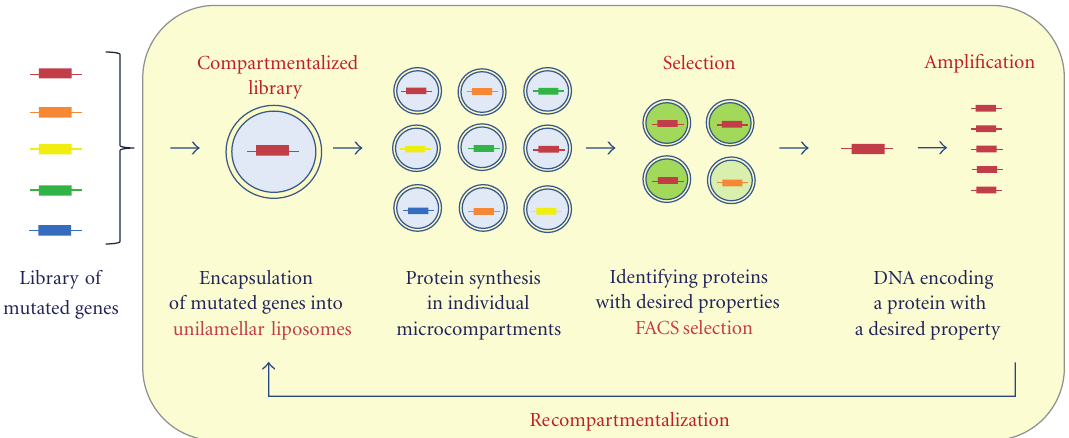
Figure 6: Flow chart for protein screening using liposome-based IVC. Library of mutated genes are compartmentalized with PURE system and other reagents into liposome. Each protein variant is synthesized from a single copy of gene in each liposome. Liposomes encapsulating the gene of interest are screened using an FACS. DNA extracted from the liposomes is amplified to be transferred to the next round of gene